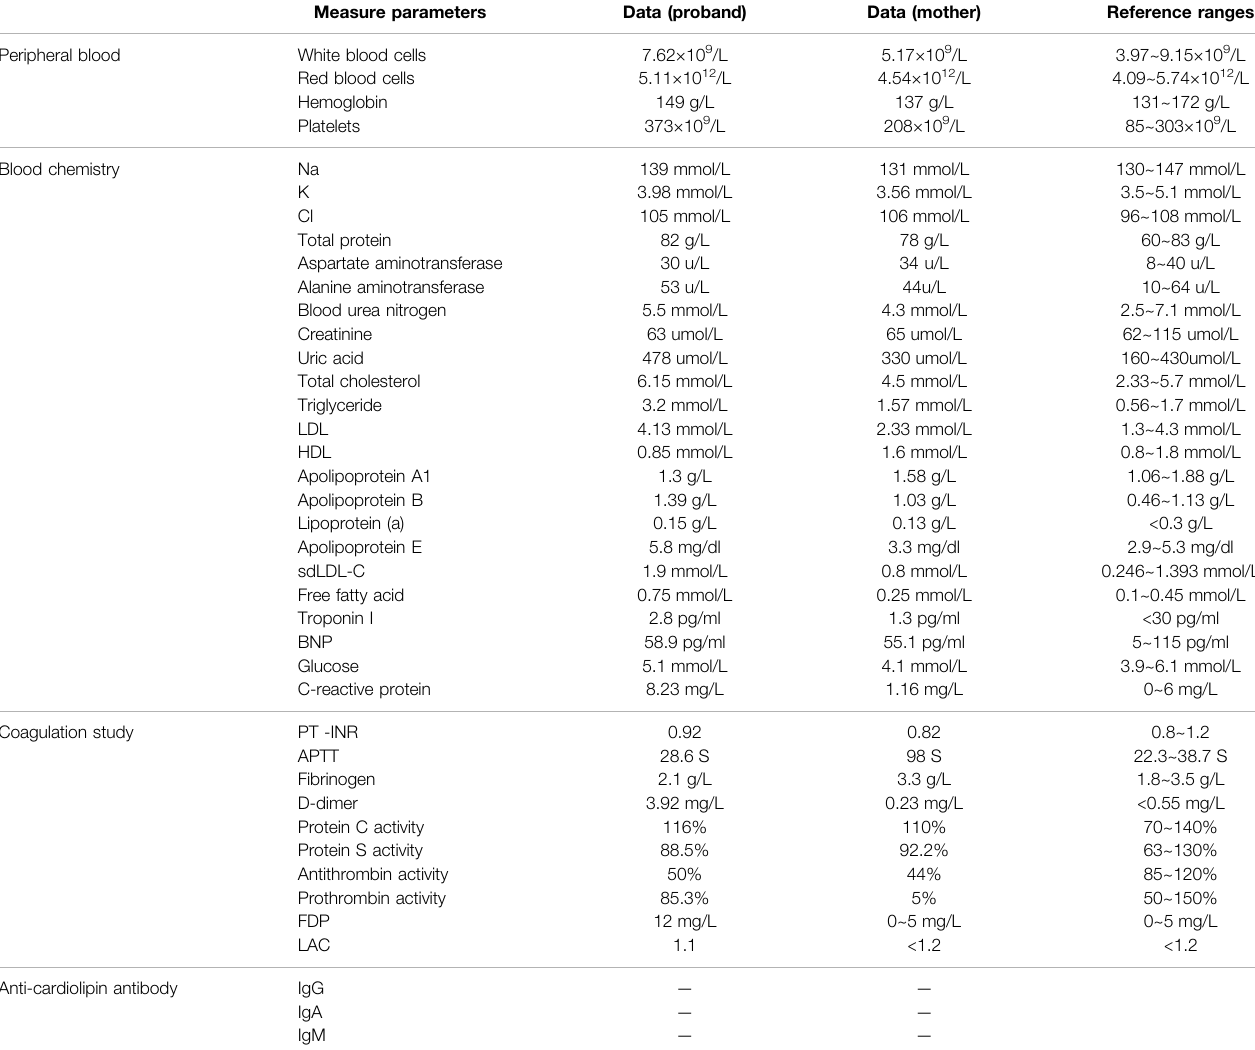
TABLE1 | The laboratory data of the